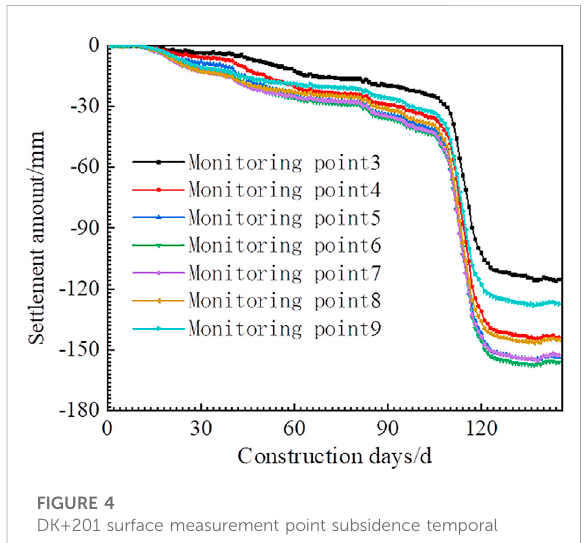
FIGURE 4 DK+201 surface measurement point subsidence temporal